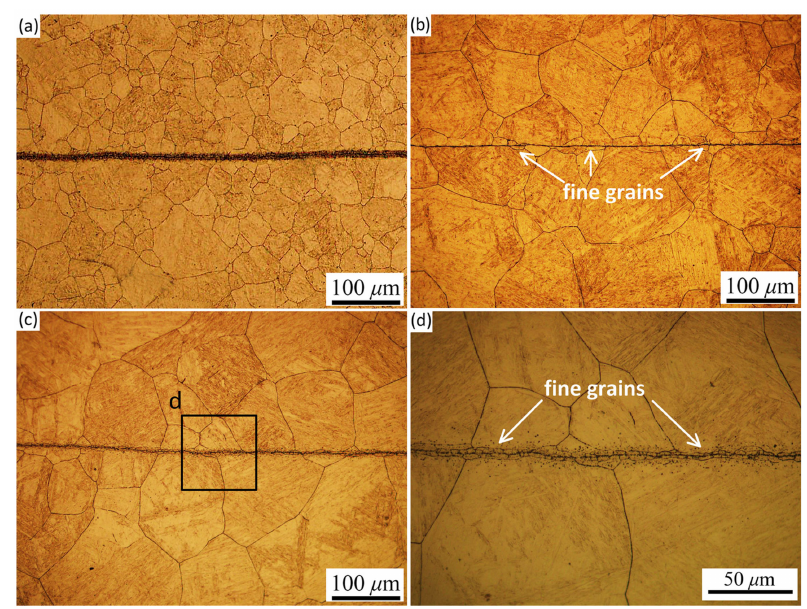
Figure 3. OM micrographs of the crack healing zone at different healing times for 60 min: ( a ) 900 ◦ C; ( b ) 1000 ◦ C; ( c , d ) 1100 ◦ C; and ( d ) the magnified image of Figure 3c showing fine recrystallized grains in the crack healing zone.